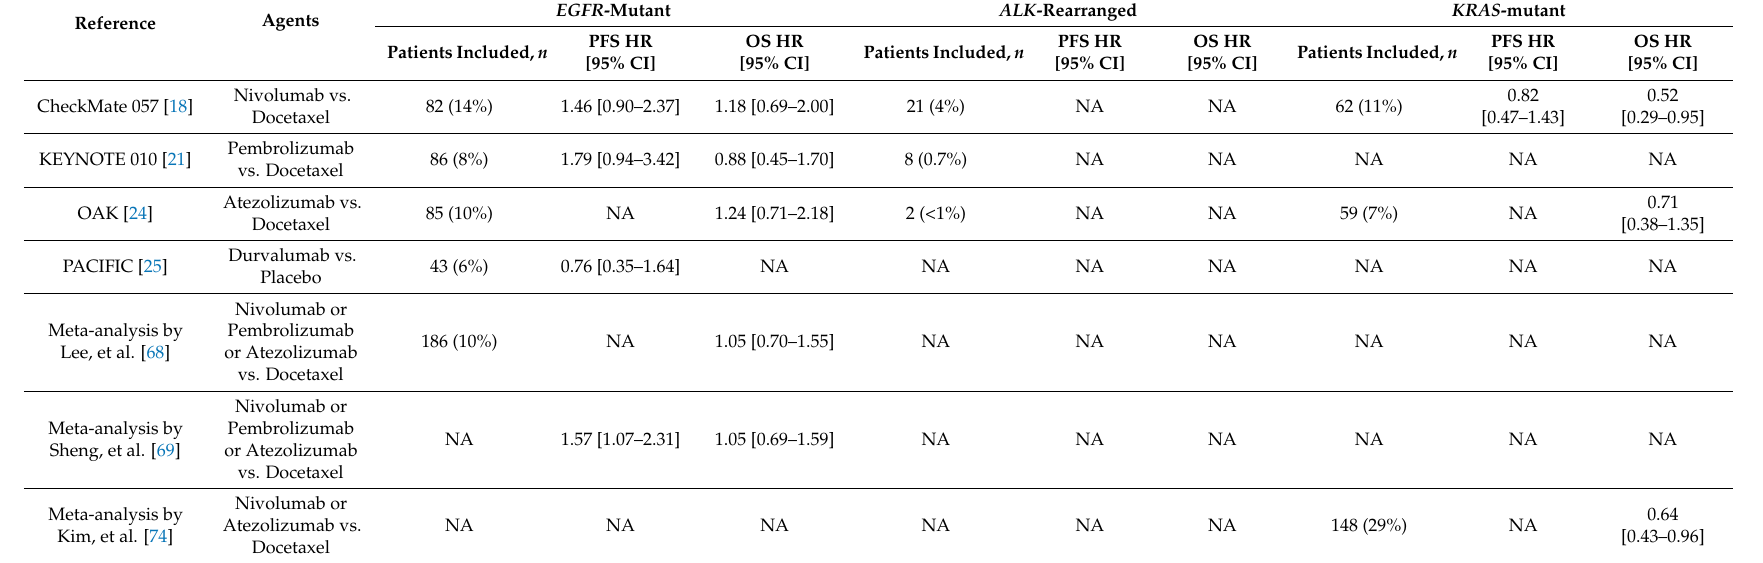
Table 1. The efficacy of immune checkpoint inhibitors (ICIs) in oncogenic-driven non-small cell lung cancer